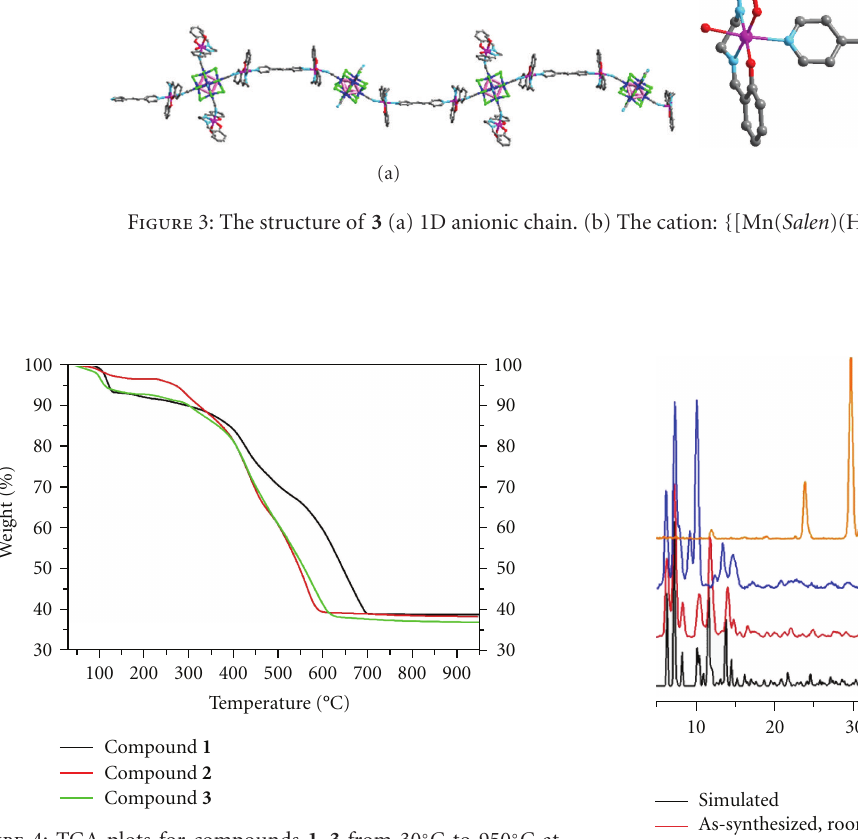
Figure 4: TGA plots for compounds 1 – 3 from 30 ◦ C to 950 ◦ C at 5 ◦ C/min under air flow (40mL/min).